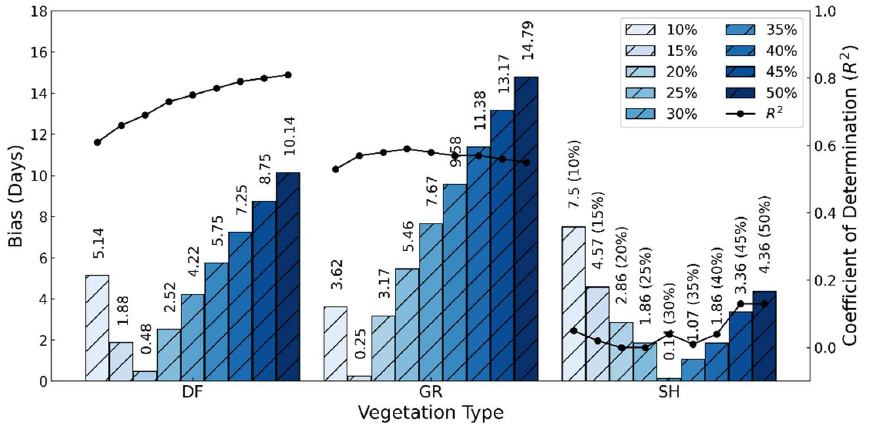
Figure 8. Bias and coefficient of determination between green-up dates derived from SGLI and near- surface observation. Results are separated according to vegetation type (DF: deciduous forest; GR: grassland, SH: shrub). Progressively darker shades of blue designate green-up dates corresponding to different thresholds (10% to 50% of a threshold by 5% step).